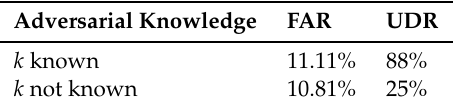
Table 3. Results for the adversarial news scenario.